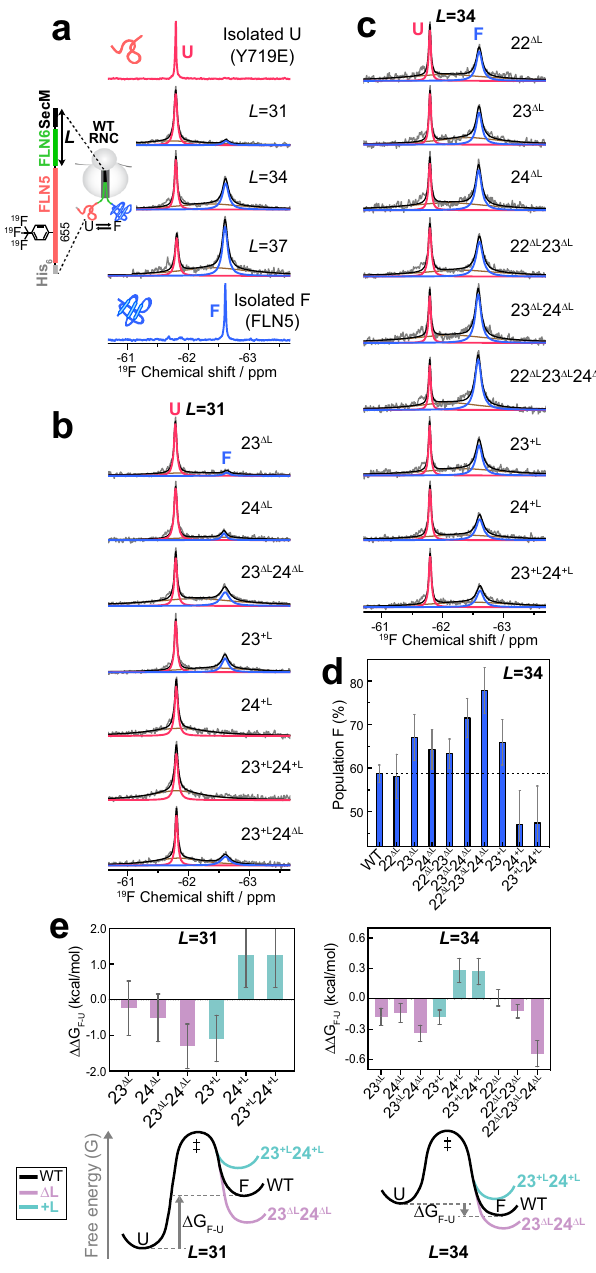
Fig. 2 Modulation of nascent chain folding in ribosomal variants. a 1D 19 F NMR spectra of unfolded (Y719E) and folded (WT) isolated FLN5, and ribosome-bound FLN5 (WT ribosomes). For RNCs, grey spectra show the recorded spectra, while red, blue and brown peaks represent the fi tted U and F state and baseline, respectively. Black spectra show the sum of the three fi tted peaks. b , c 19 F spectra of FLN5 RNCs with mutant ribosomes at L = 31 ( b ) and L = 34 ( c ). d Population of F state of RNCs at L = 34 calculated from 19 F NMR analysis. The dotted line represents the F state population of the WT RNC (58%). Errors are standard deviations (s.d.) calculated by Hamiltonian Monte Carlo analysis during the fi tting of real and imaginary components of the FID simultaneously. e The changes in the free energy of folding ( ΔΔ G F-U ) arising from each loop modi fi cation at L = 31 and 34. Error is calculated by propagating the errors of P F and P U (see ‘ Methods ’ ). For the variants for which no F state signal was detected (24 + L , 23 + L 24 + L , L = 31), maximum ΔΔ G F-U was estimated based on the assumption that P F < 1% (See ‘ Methods ’ ). Free energy landscapes of folding at L = 31 and 34 are shown under the bar